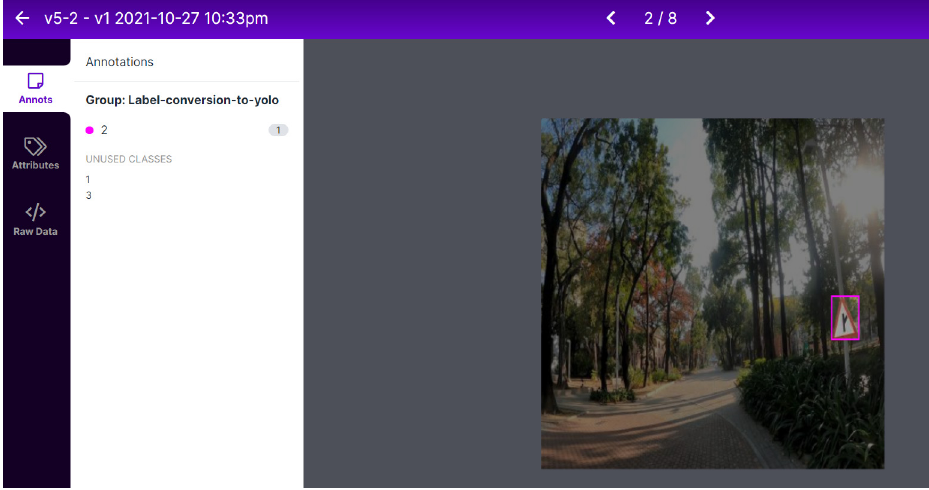
Figure 11. Annotations conversion to YOLO format via Roboflow.